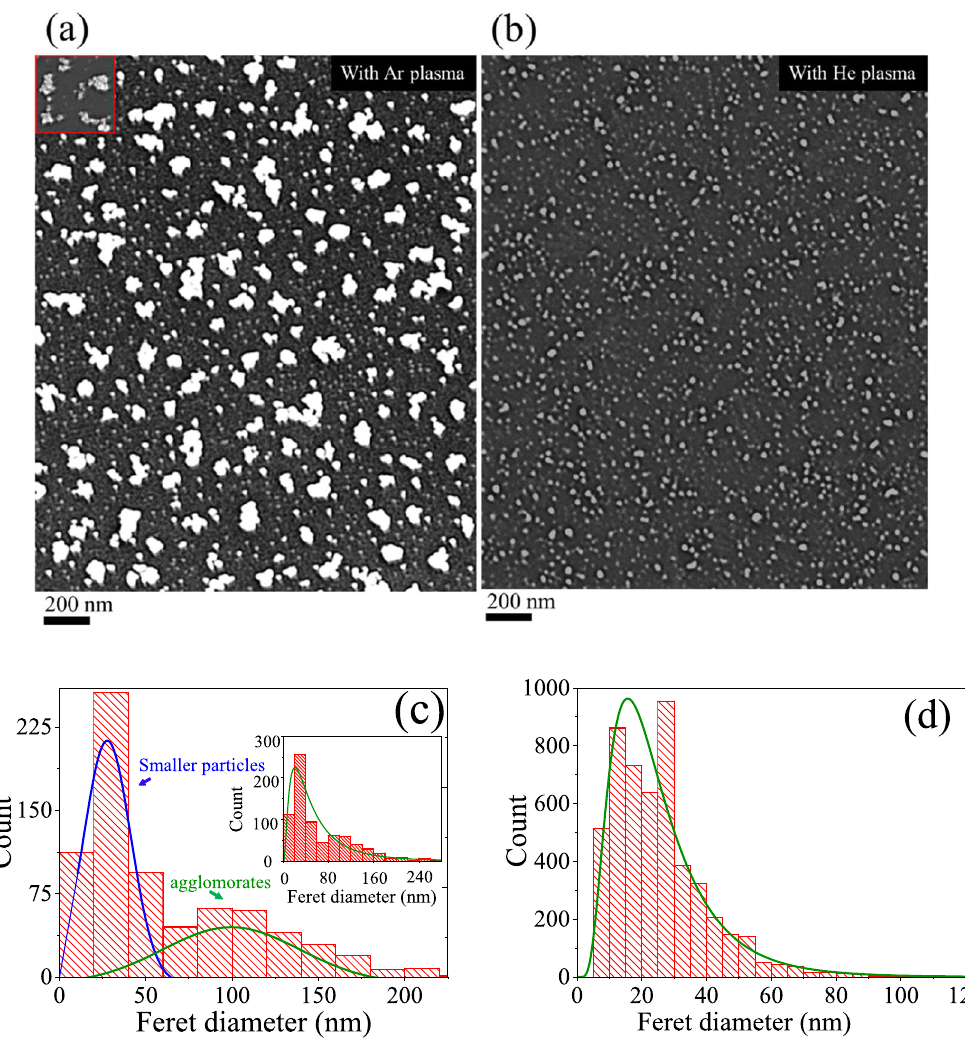
Figure 3. SEM images of nanoparticle aerosols processed with ( a ) argon and ( b ) helium plasma jets and collected downstream the tube on a silicon substrate. Feret diameter distributions are given in ( c , d ). The inset in ( a ) is a small patch at a different contrast while the inset in ( c ) is the overall distribution for the whole